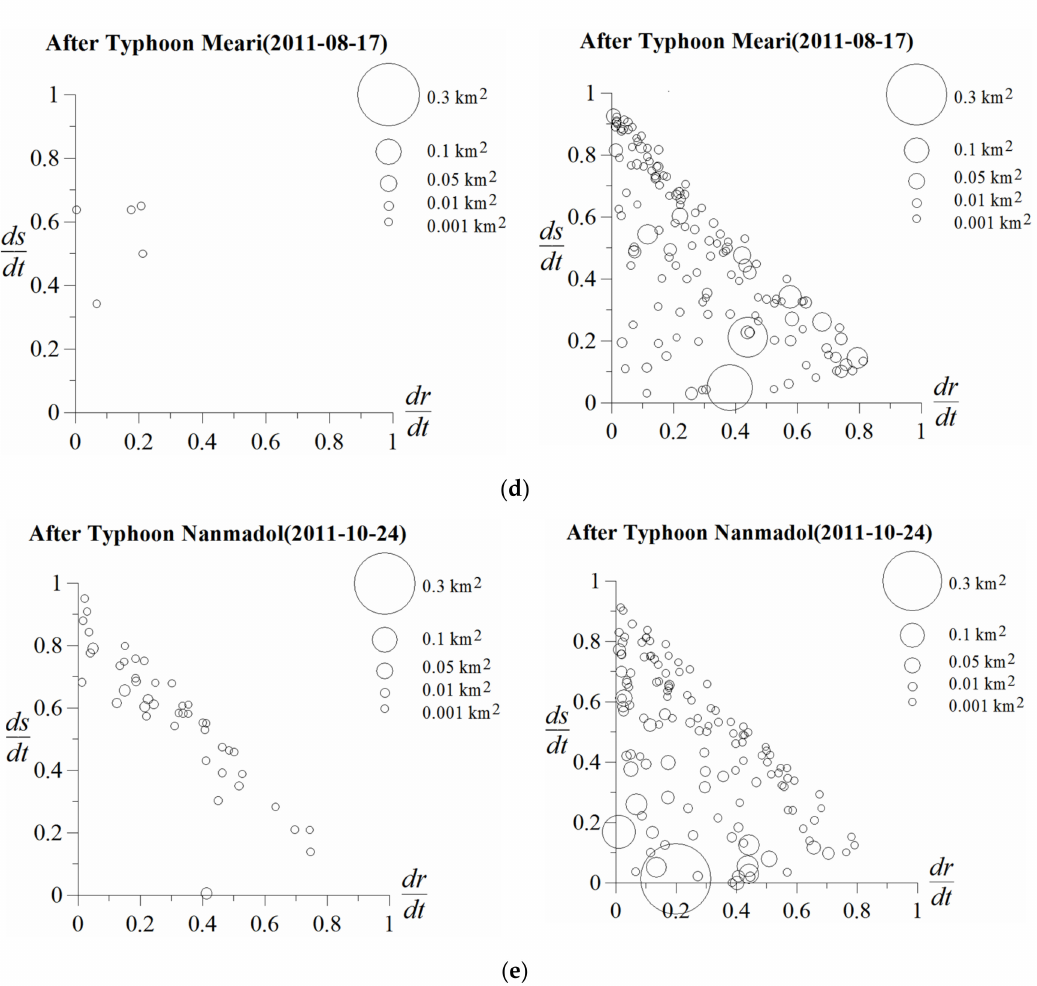
Figure 9. Plot of ds/dt against dr/dt for the new landslide (left) and second landslide (right) after ( a ) heavy rainfall on July 27, 2010, ( b ) Typhoon Meranti (2010), ( c ) Typhoon Fanapi (2010), ( d ) Typhoon Meari (2011), and ( e ) Typhoon Nanmadol